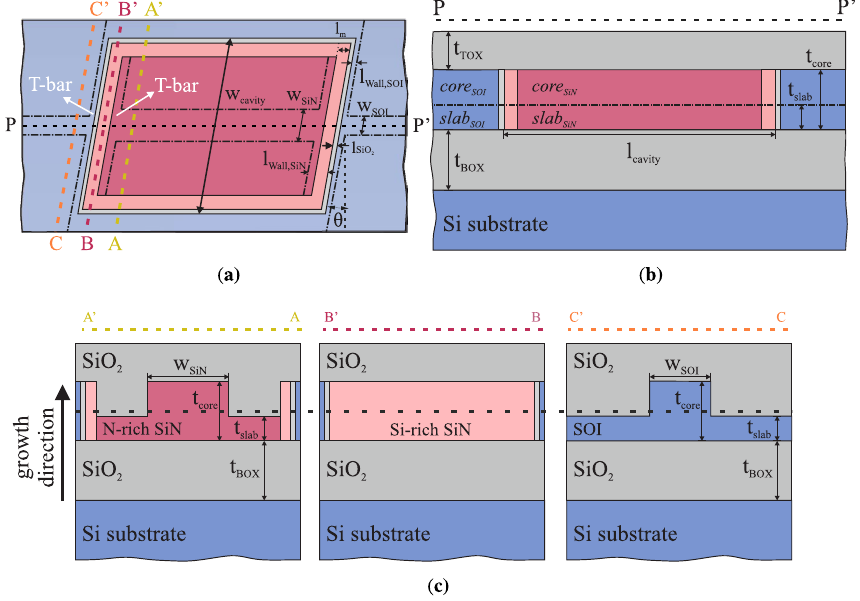
Figure 1. Waveguide-to-waveguide butt-coupling interconnection concept. In (a) the top view of the interconnection is depicted. The N-rich SiN section stands in the middle and its facets are connected to the SOI waveguides. Descriptive transverse cuts are taken to elucidate the full geometry of the device. The PP’ dashed line reveals the side view of the structure depicted in (b) . Cross-sections of the separate elements of the structure are disclosed in (c) . The cuts AA’ and CC’ reflect to the N-rich SiN and the SOI sections, respectively. BB’ refers to the Si-rich SiN layer that is set, along with the SiO 2 layer, between the two passive platforms towards optimal photonic coupling.